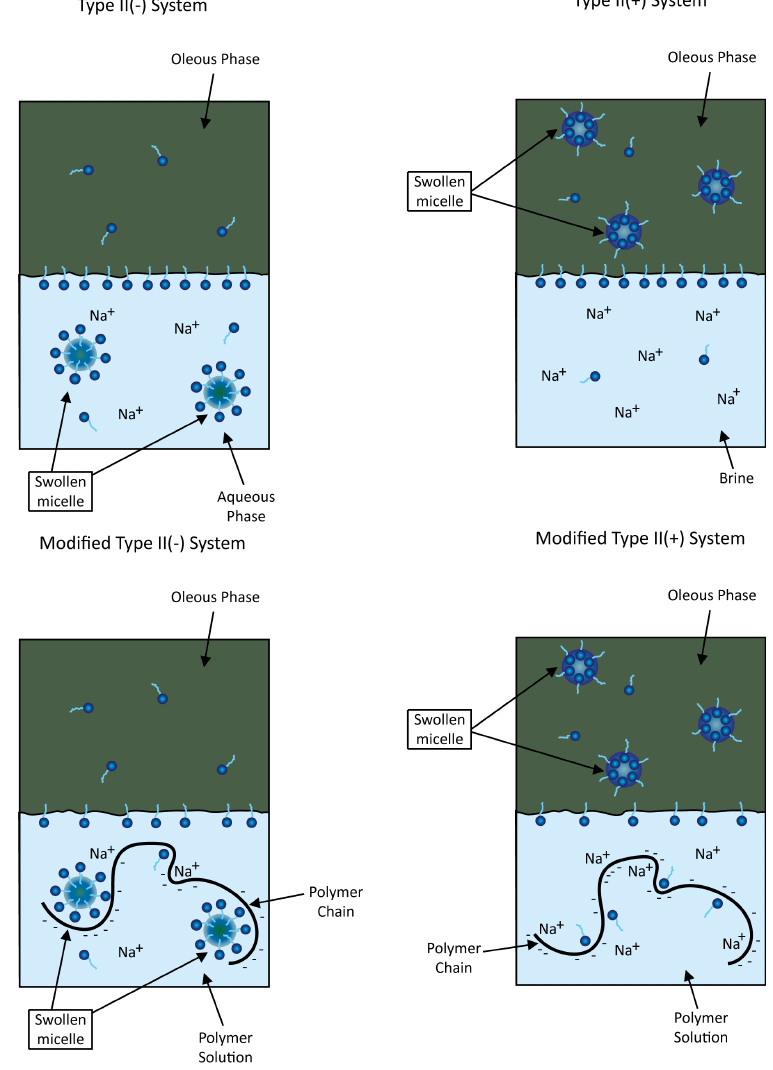
Figure 1. Polymer—Surfactant interactions and their effect on the IFT (Adapted from Druetta